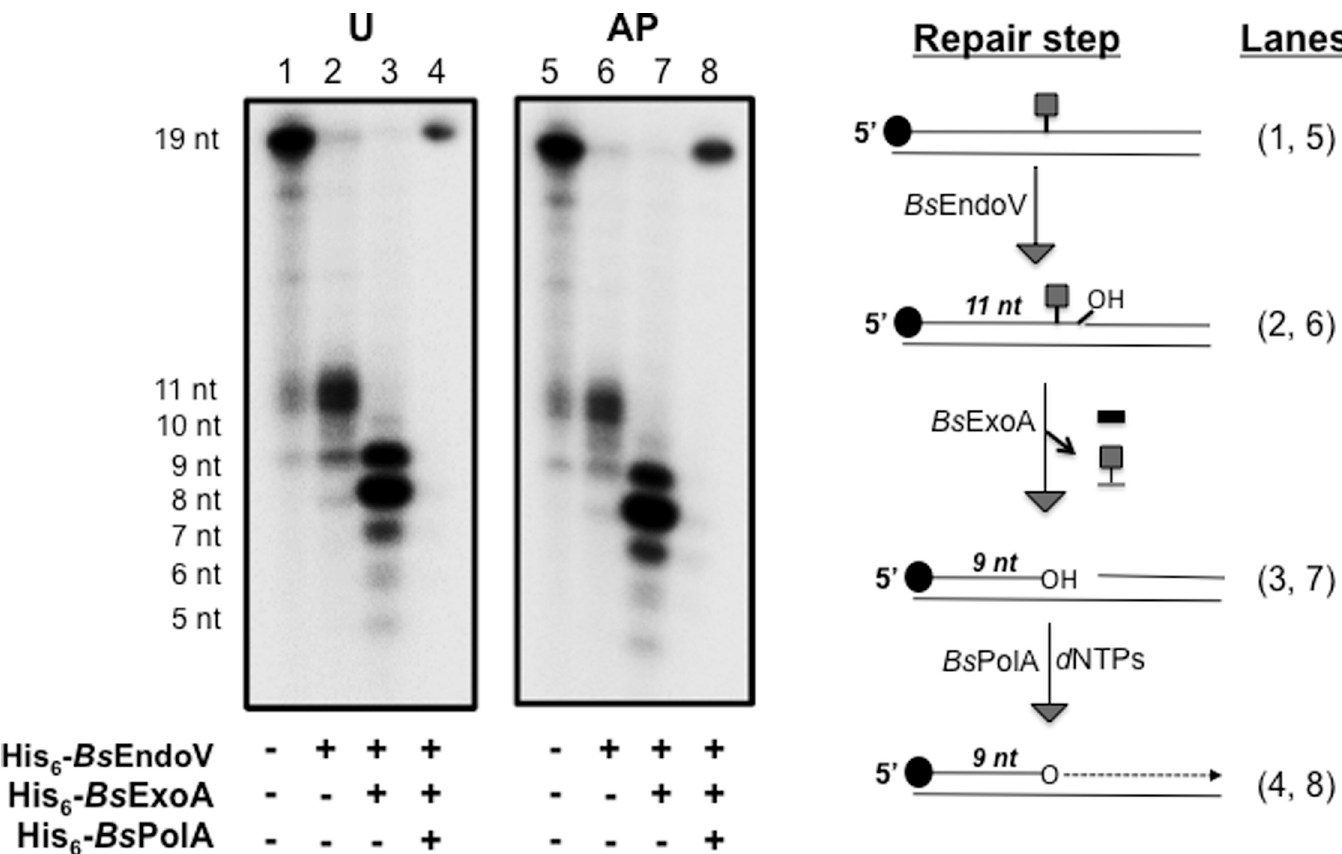
Fig 6. Capacity of B sExoA to remove Bs EndoV-repair intermediates and completion of repair by Bs PolA. 19-mer-ds-DNAs containing U (lane 1) or an AP-site (lanes 5) were subjected to incision by Bs EndoV to generate ds-DNA products with a single nick in the 11 th phosphodiester bond inaccessible to Bs PolA-dependent DNA synthesis (lanes 2 and 6). Addition of Bs ExoA to these repair products resulted in the efficient removal of nucleotides in the 3’ ➔ 5’ direction, thus presumably removing the DNA damage (lanes 3 and 7). Finally, DNA synthesis was performed by Bs PolA completing the repair process (lanes 4 and 8). The distinct repair steps are schematically presented next to the autoradiograms with corresponding lane numbers. U or AP ( ■